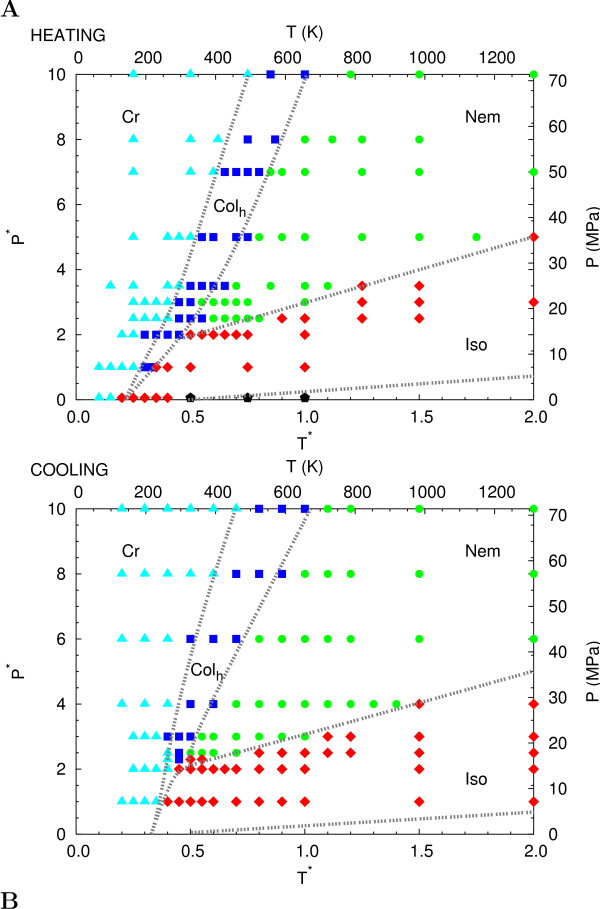
Heating and cooling P-T phase diagrams of chargeless system. Pressure-temperature phase diagram of system Q0 derived by heating (A) and cooling (B) sequences of MC simulations. The symbols denote the states where we carried out the simulations: cyano triangles for Cr phase, blue squares for Colh, green circles for Nem, red diamonds for Iso, black pentagons for Gas. The gray dashed lines are a guide to eyes suggesting the phase boundaries. Both scaled (starred) and real values (see text) for P,T are reported.